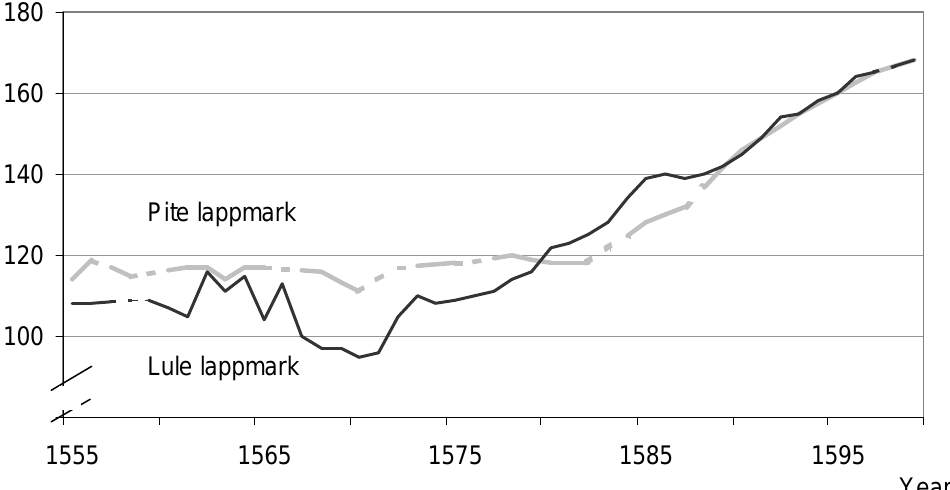
Fig. 3. The population growth in Pite and Lule lappmark 1555-1599. The general tendency was the same in Torne lappmark, but the figures are less precise. (Lundmark, 1982, p. 191 sqq.; Bergström,